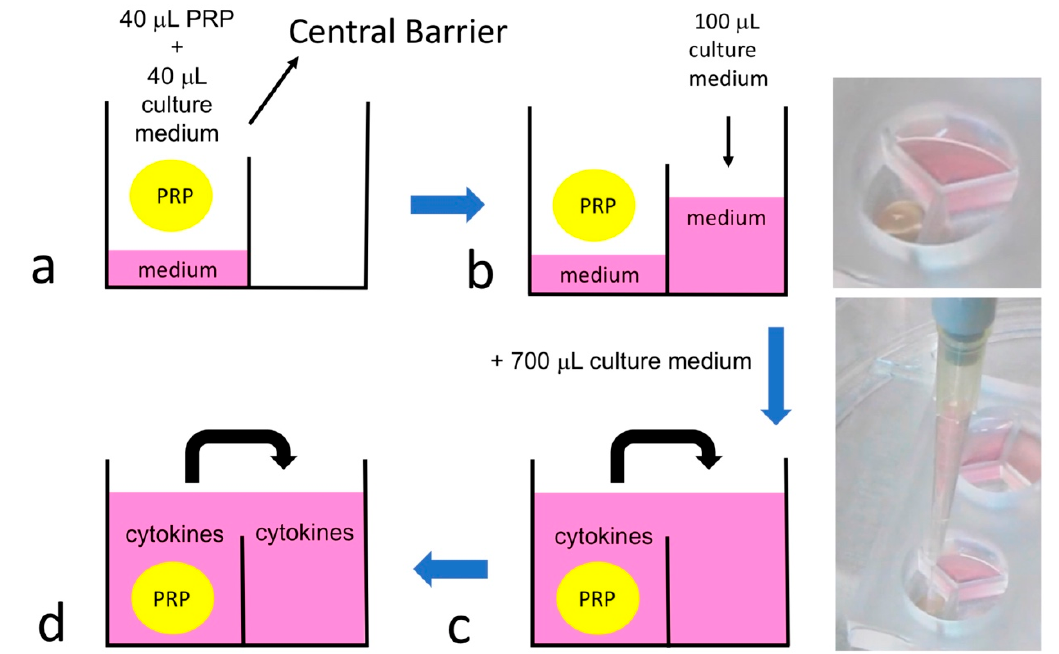
Figure 5. The idea of platelet-derived cytokines diffusion in the 3-chamber co-culture system. ( a ) 40 μ L PRP and 40 μ L culture medium were added to one sub-chambers of the co-culture device. ( b ) Then, 100 μ L culture medium were added to each of the other two sub-chambers. ( c ) After gelling of the PRP overnight, 700 μ L culture medium was added to the whole culture well to cause the culture medium to cross the central barrier. ( d ) The platelet-derived cytokines released in the medium would diffuse to all 3 sub-chambers.